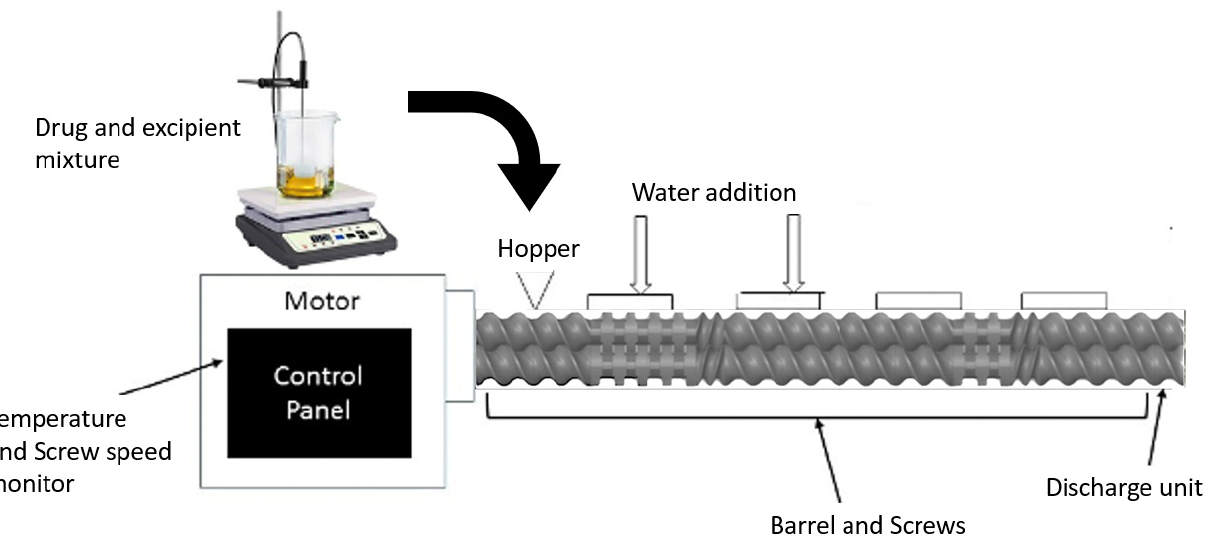
Figure 1. A schematic diagram representing a hot melt extruder (HME) setup for nanoemulsion Figure 1. formulation.